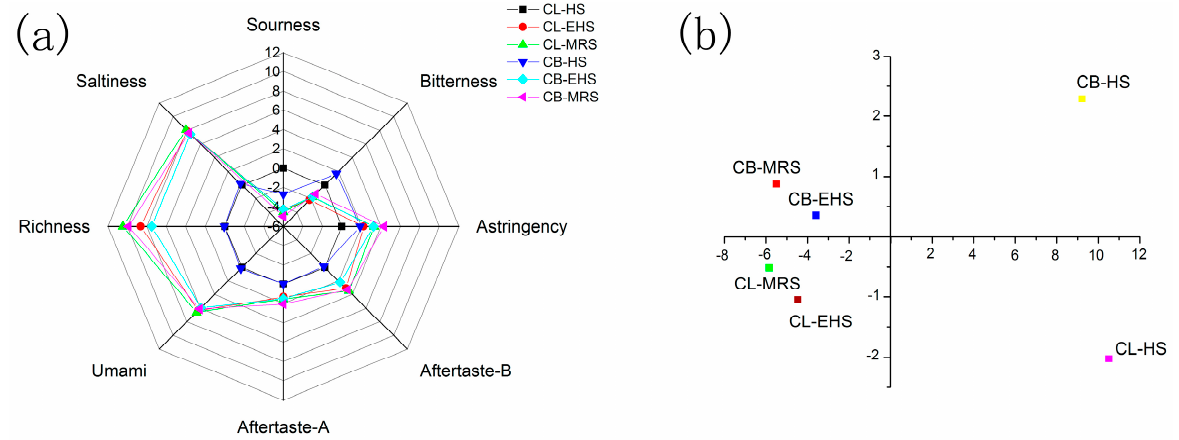
Figure 2. E-tongue patterns: ( a ) the taste polar pattern in the samples and ( b ) PCA analysis. Here, the sample flavor attributes were categorized using a principal component analysis (PCA) [18]. The total ratio of both principal component analyses for the crab legs and body was 98.83%, with PC1 (93.00%) and PC2 (5.83%). The CB-HS and CL-HS are separated in the first and fourth quadrants, showing that these two raw materials, without processing, have different flavor patterns. After processing, the CB-EHS and CB-MRS were in the second quadrant, while the CL-EHS and CL-MRS were in the third